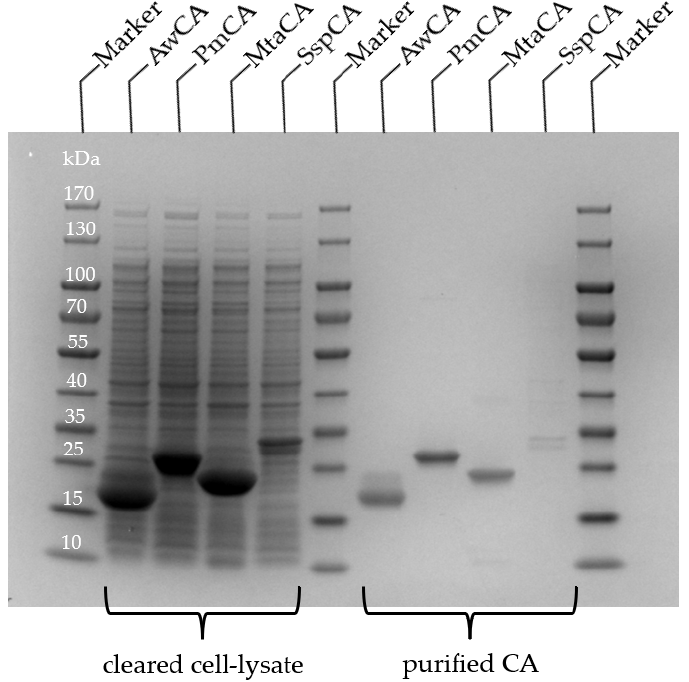
Figure 2. SDS-PAGE of CAs produced in E. coli . Samples of cleared cell lysate and after purification by affinity chromatography. Expected molecular masses are 22.0 kDa (AwCA), 26.9 kDa (PmCA), 19.9 kDa (MtCA) and 27.5 kDa (SspCA).